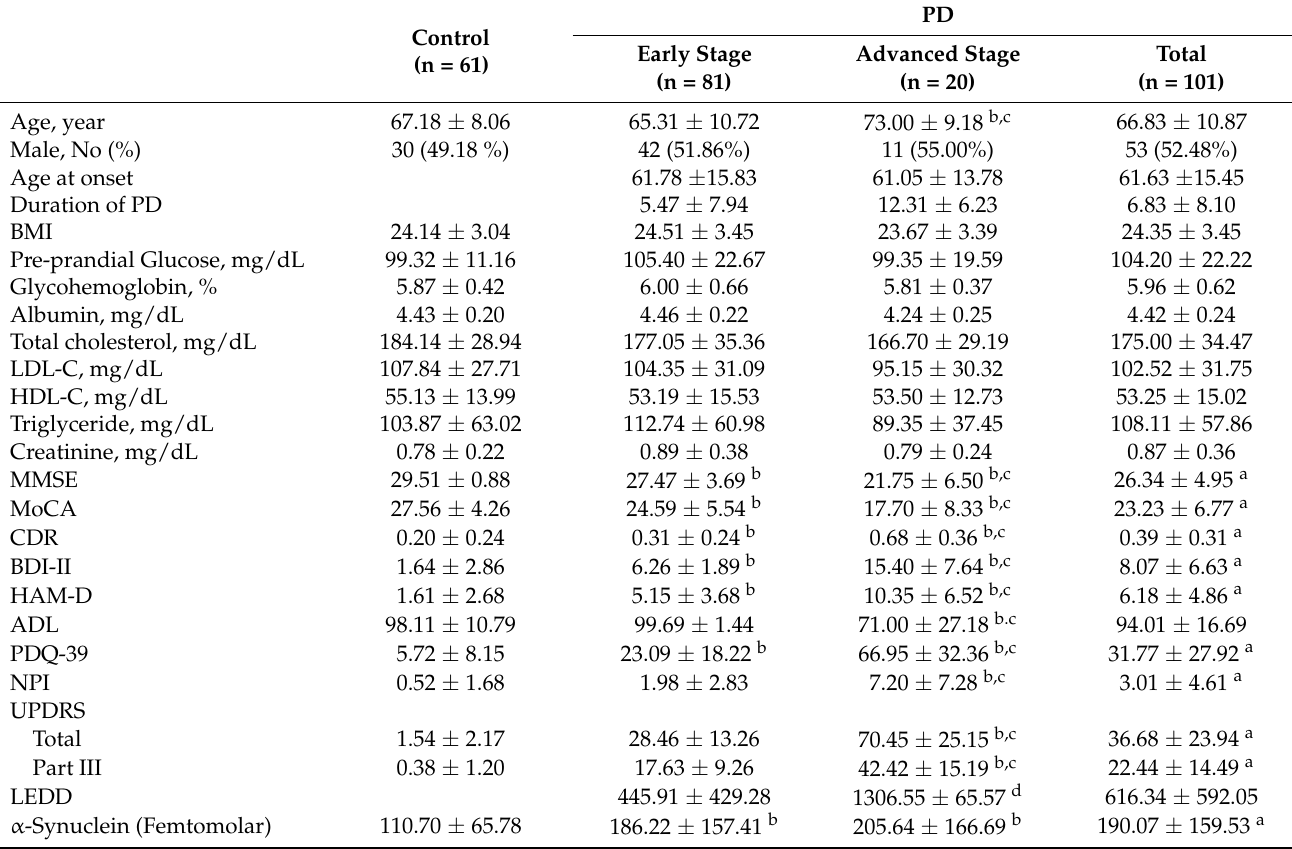
Table 3. Demographic characteristics and blood biochemical parameters of the validation